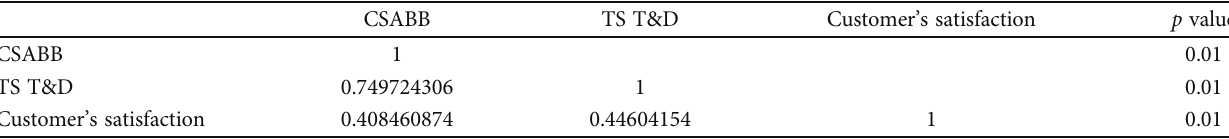
Table 9: Correlation analysis of the variables.